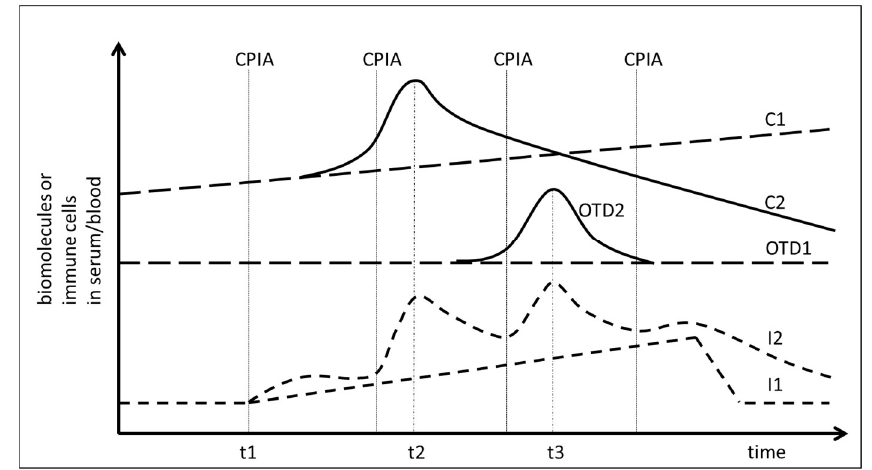
Figure 1. Analysis of temporal correlation of immune activation and release of biomolecules into the serum of cancer patients treated with checkpoint inhibition (CPI). t1: Start of CPI. CPIA: Administration of checkpoint inhibitors. C1: release of cancer-derived proteins or DNA in the absence of a response to CPI. C2: Release of cancer-derived proteins or DNA in response to CPI at time point t2. OTD1: Release of organ tissue derived biomolecules without immune mediated tissue damage. OTD2: Increase of organ tissue derived biomolecules due to treatment-induced and immune-mediated tissue damage at time point t3. I1: Continuous increase of immune activity under CPI. I2: Non-continuous phasic increase of immune activity under